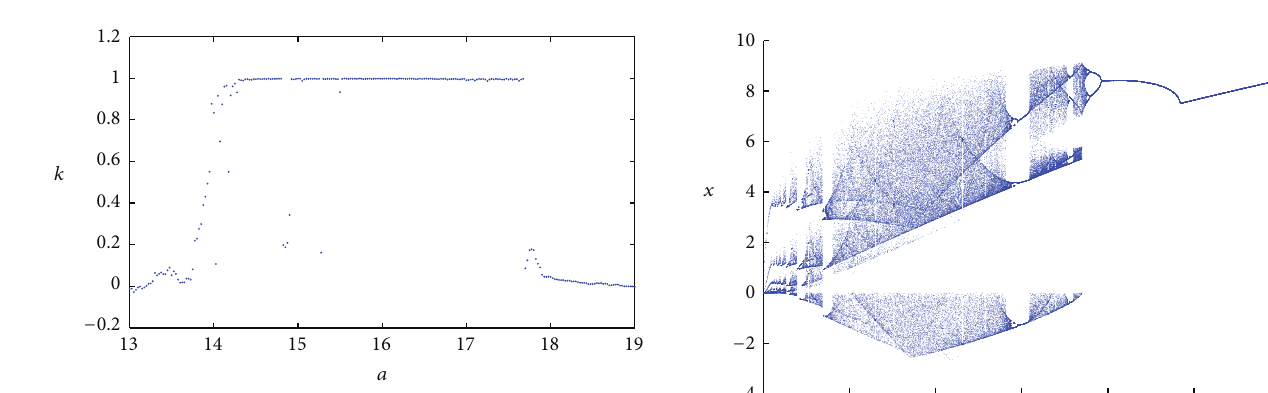
Figure 4: Implication of 0-1 test on the system with respect to 𝑎 .